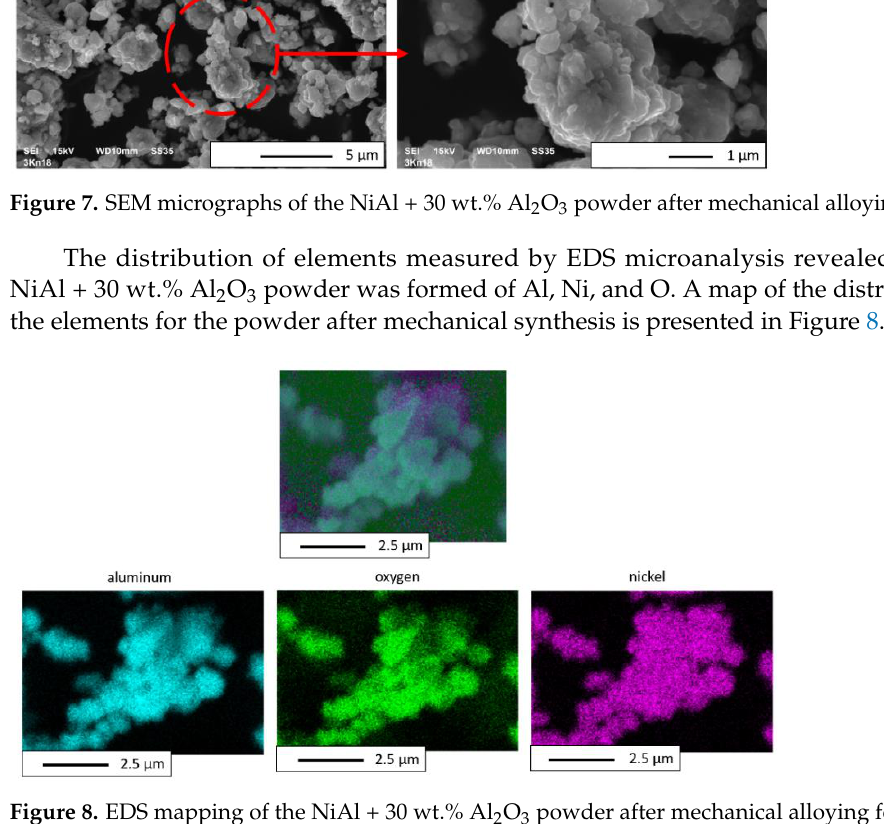
Figure 8. EDS mapping of the NiAl + 30 wt.% Al 2 O 3 powder after mechanical alloying for 18 h.